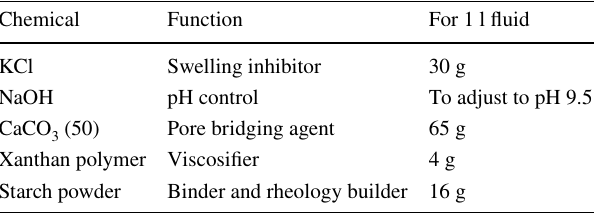
Fig. 4 FMI log of the target formation showing water encroachment (left). 3-D view of a major open fracture (right) Table 3 Chemical composition of the gelant solution (Fluid-2)